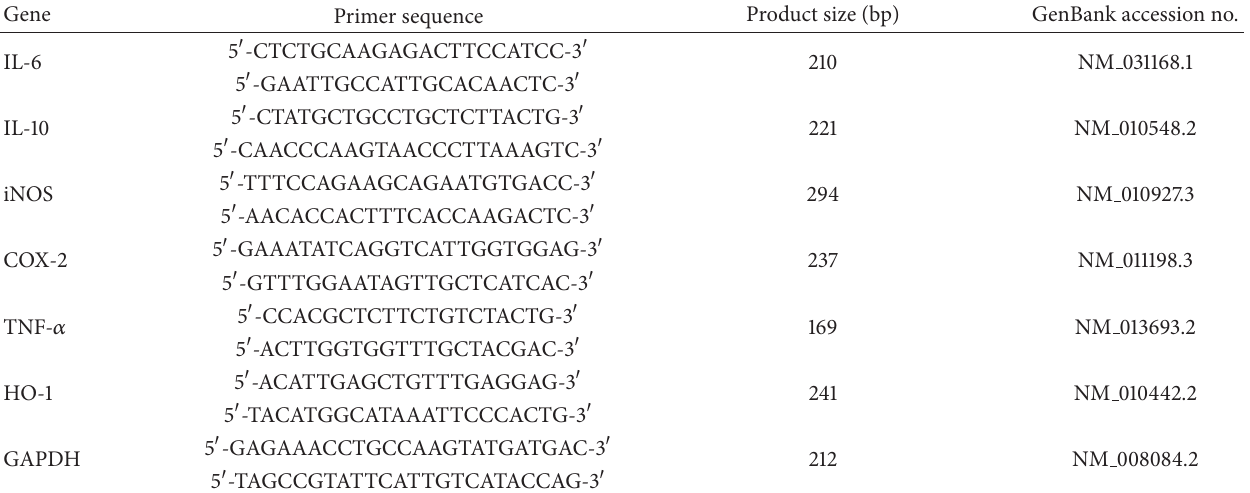
Table 1: Primer sequences used for qRT-PCR